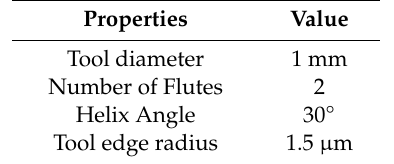
Figure 7. Uncoated tungsten carbide micro end mill (1 mm) with cutting edge radius measurement: ( a ) Top view of tool, ( b ) cutting edge radius measurement method. Table 1. Micro-end milling specifications.